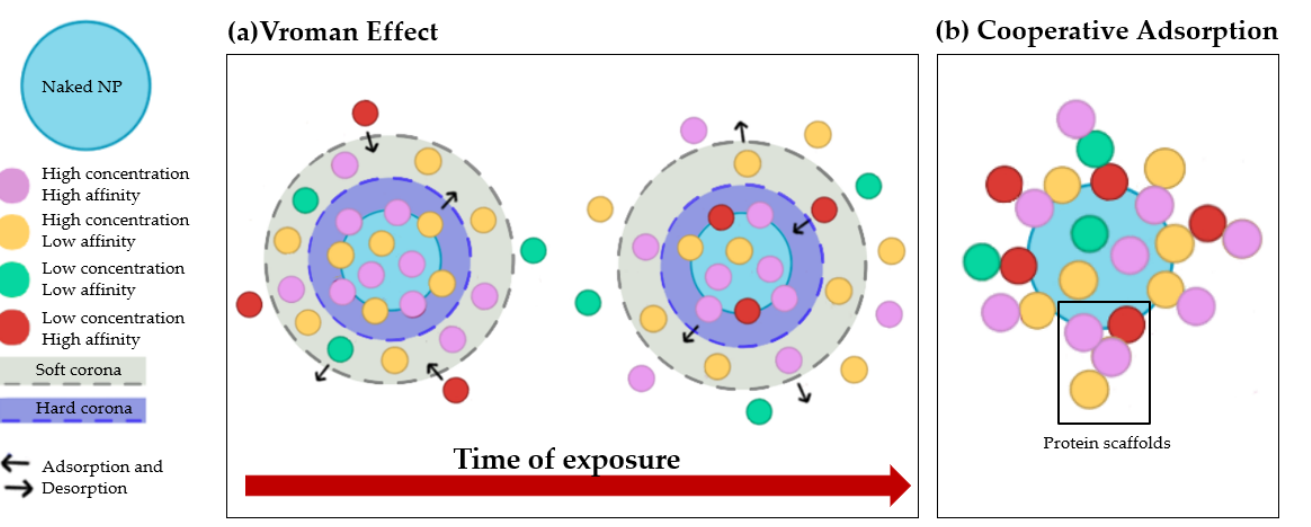
Figure 1. Overview of the phenomena that affect protein adsorption on nanoparticles. ( a ) The Vroman effect: overtime proteins with higher affinity displace proteins with lower affinity. ( b ) Cooperative adsorption: already bound proteins act as scaffold for other proteins on the NPs’ surface.